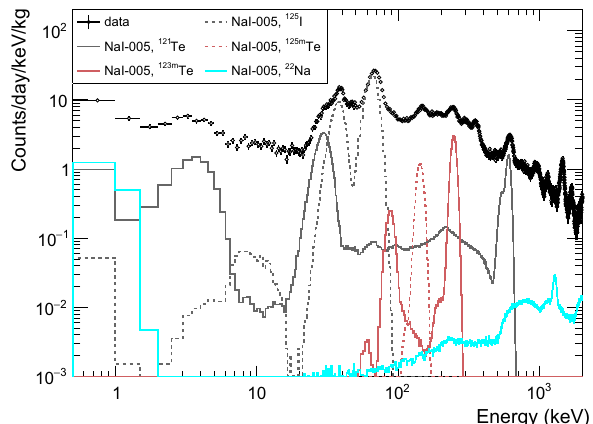
Fig. 4 Cosmogenic backgrounds for the NaI(Tl) crystal with the CsI(Tl) crystal array